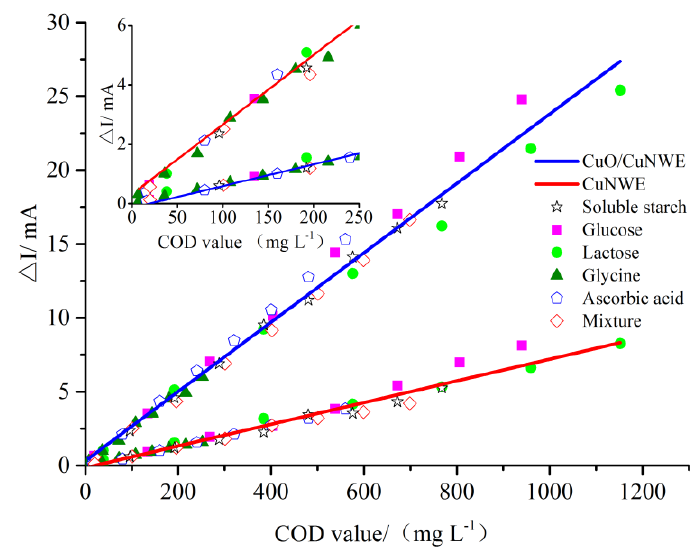
Figure 8. The net increase in cathodic peak current ( ∆ I) versus theoretical COD values of four organics (glucose, lactose, glycine and ascorbic acid), their mixtures, and soluble starch in a 0.075 M NaOH solution. Inset is the magnified view at low COD values. Table 1. Comparison between the reported Cu-based sensors and the one described in this work. Electrochemical Sensors Based